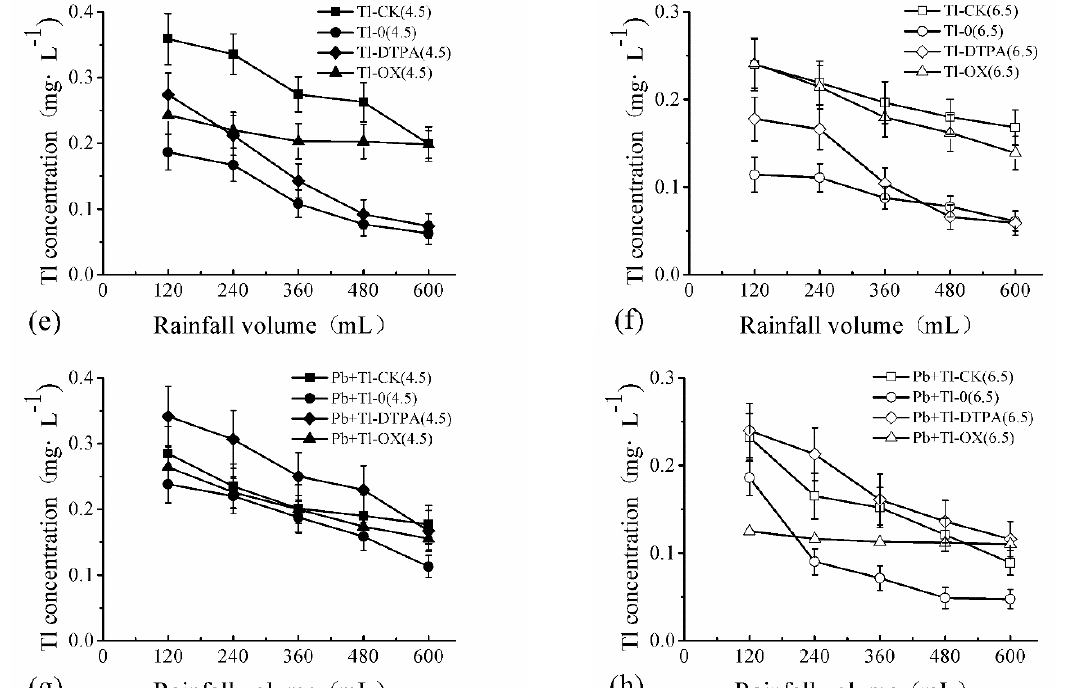
Figure 2. Concentrations of Pb ( a – d ) and Tl ( e – h ) in the leachates of DTPA- and oxalic acid-treated soil in the leaching experiment. Error bars are the standard deviation (SD) ( n = 3). CK = no maize; 0 = no chelating agents; DTPA = 2.5 mmol kg − 1 soil; oxalic acid = 2.5 mmol kg − 1 soil.